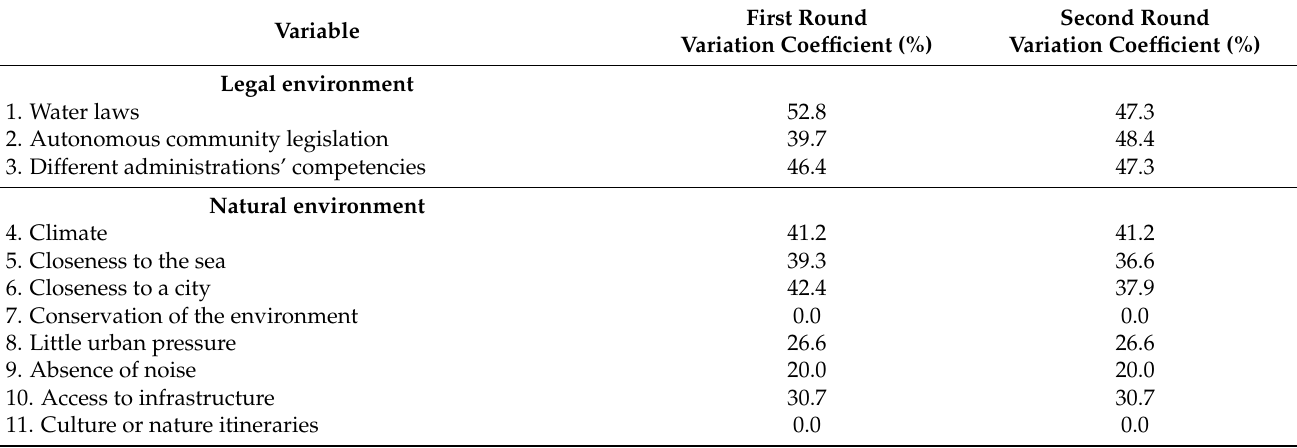
Table 5. Dispersion of criteria of experts in thermal tourism in first and second rounds ( n = 22) a.